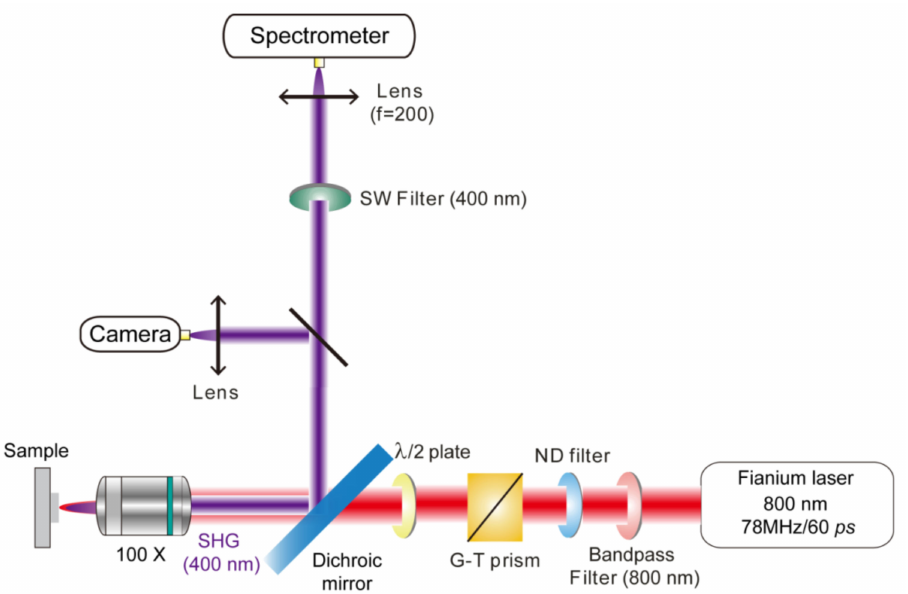
Figure 2. Experimental setups for the second-harmonic generation (SHG)